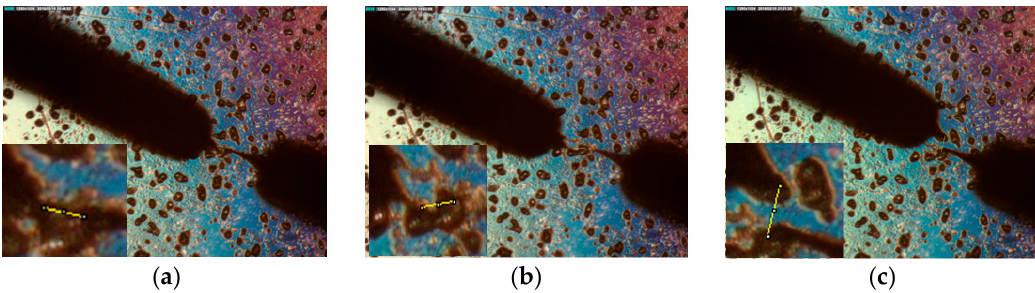
Figure 7. Microparticle measurement experiment as visualized with the optical microscope at distances of 22 μ m, 45 μ m, and 56 μ m between the tips. ( a ) Both tips over the same microparticle; ( b ) tips over microparticles in contact with each other; ( c ) tips over microparticles that are not in contact with each other.